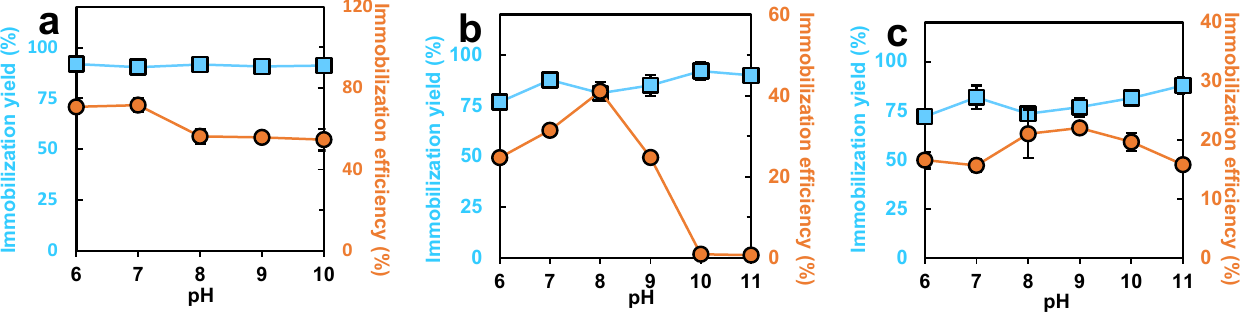
Figure 2. The effect of pH on immobilization (blue rectangle: immobilization yield, yellow sphere: immobilization efficiency, ( a ) FLS, ( b ) ADH, and ( c ) NOX). 3.3. The Effects of the Immobilization Time and the Enzyme Carrier Ratio on the Immobilization With increasing time, the immobilization yields of ADH and NOX increases, yet the immobilization efficiency declines. This is because the linkage between the enzyme mol- ecules and epoxy-based modified carriers was facilitated by the increased immobilization time. At the same time, the increase in the immobilization time reinforced the loss of en- zyme activity as well [45]. Unlike the previous two enzymes, FLS did not present the ex- pected descent in immobilization yield. This might be related to two causes, the posses- sion of side-chain amino groups with a higher reactivity than FLS and the consistently high apparent immobilization yield due to the adsorption of FLS on the carrier. Physically adsorbed proteins were difficult to count because of their low concentration in the wash- ing solution. Therefore, the immobilization yields for 1 h were significantly lower than the others (Figure 3). Ultimately, 2, 1, and 2 h were determined as the immobilization time for FLS, ADH, and NOX, respectively. Figure 3. The effect of the immobilization time on the immobilization of enzymes (blue rectangle: immobilization yield, yellow sphere: immobilization efficiency, ( a ) FLS, ( b ) ADH, ( c ) NOX). The carrier was expected to be able to load as many enzymes as possible for the cat- alytic reaction, but an excess of enzyme can lead to a thick enzyme shell. This produced severe mass transfer resistance, which caused a loss of enzyme activity [46]. Therefore, the ratio of enzyme to the carrier was also evaluated for a higher immobilization efficiency (Figure 4). The immobilization yields of ADH and NOX increased, yet the efficiency of the immobilization decreased as the amount of enzyme increased. When the ratio of enzyme to carrier exceeded 15, there was a tendency for both the immobilization efficiency and the yield to decrease as the carrier reached its maximum loading capacity. Ultimately, 20, 10, and 10 mg·g − 1 were selected as the enzyme carrier ratio of FLS, ADH, and NOX, re- spectively (Figure 4).